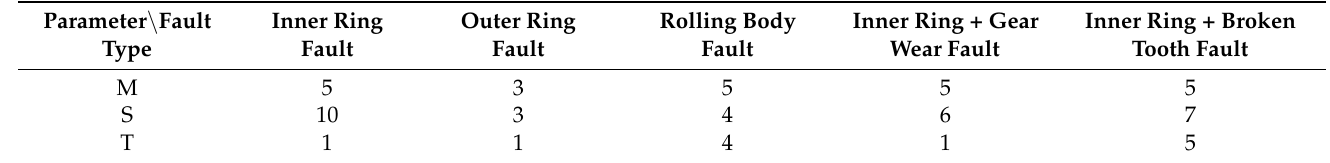
Table 4. Multiscale Fuzzy Entropy parameters for five kinds of